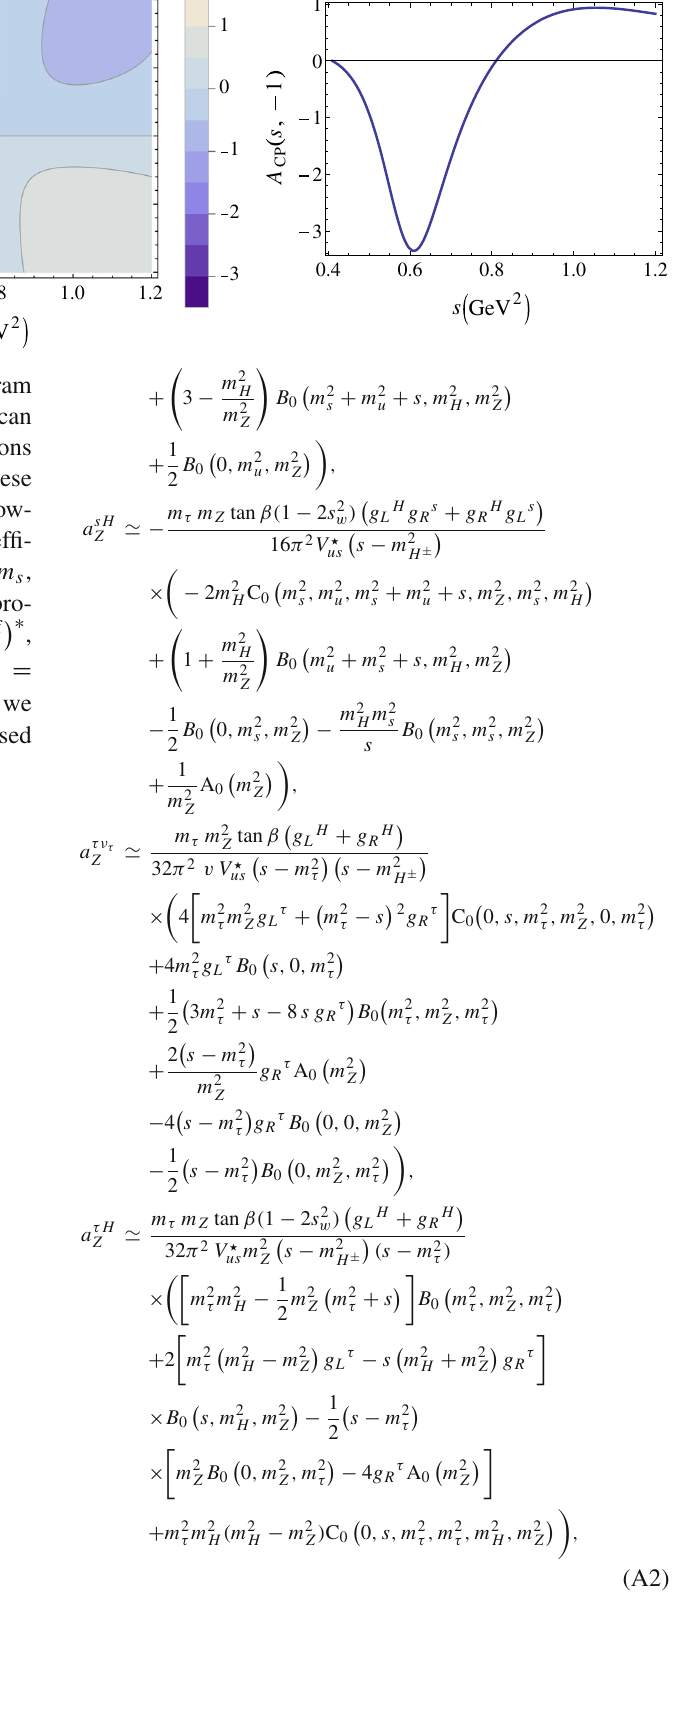
Fig. 2 Local CPV, in units of 10 − 3 as a function of s and x = cos θ and the same but for x = −